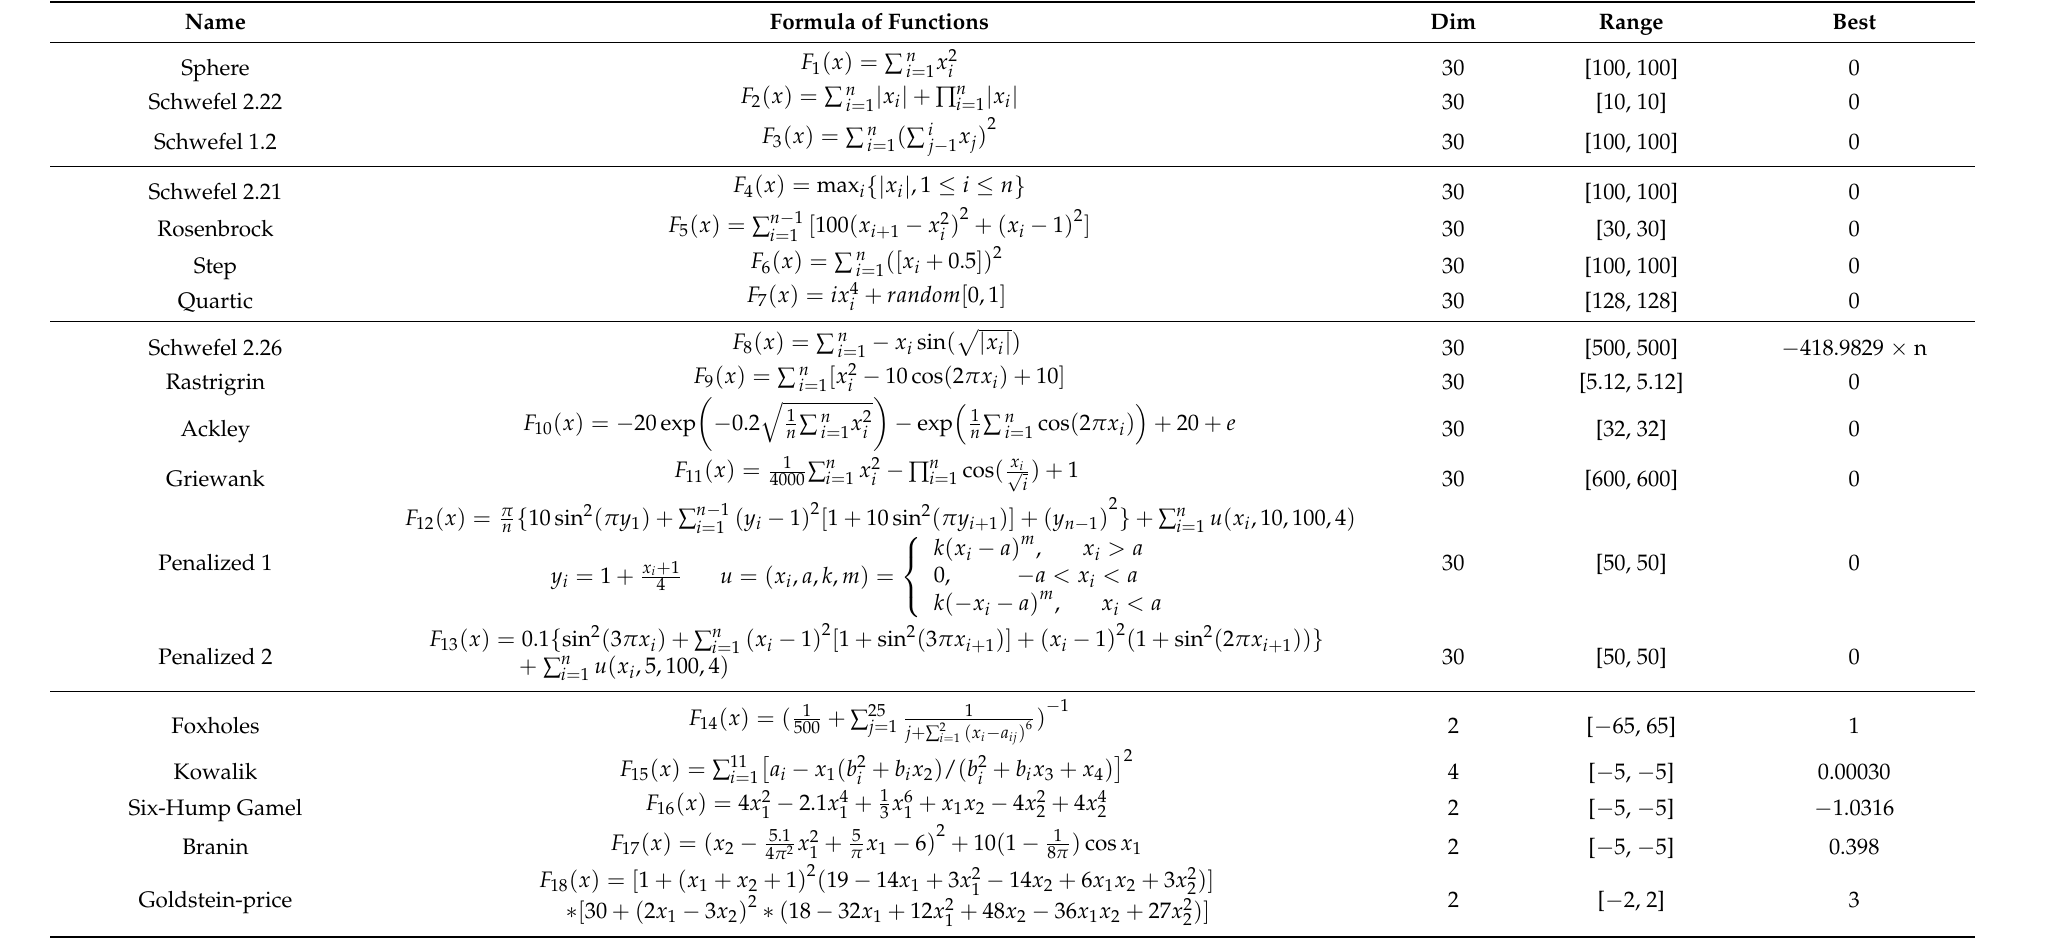
Table 1. Benchmark